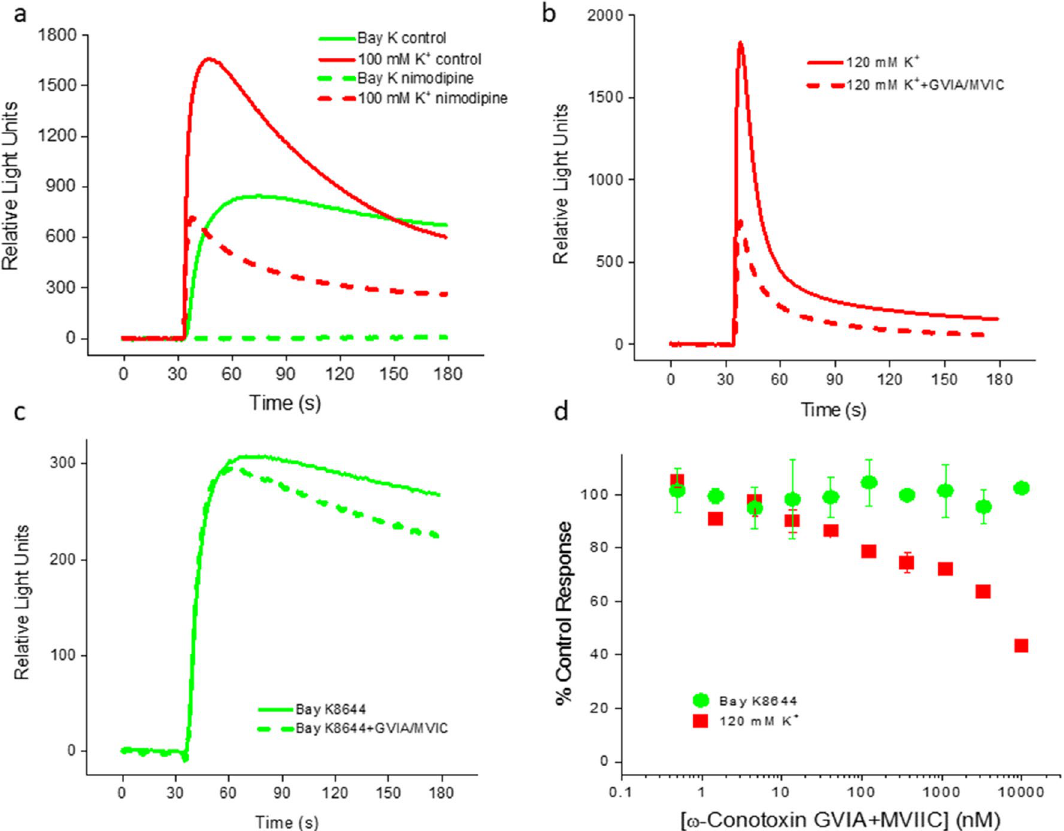
Figure 1. Functional expression of LTCCs and other VGCCs in rat cortical cultures. ( a ) Calcium fluorescent responses to stimulation by high [K + ] (100 mM; solid red line) and Bay K8644 (1.1 µM; solid green line). Nimodipine (3 µM) partially (dashed red line) and completely (dashed green line) inhibited the high [K + ]- and Bay K-evoked responses, respectively. ( b ) Calcium fluorescent responses evoked by high [K + ] (120 mM; solid line) were partially blocked by a cocktail of VGCC (but not LTCC) blockers (dotted line), ω-conotoxin GVIA (N-type) and ω-conotoxin MVIIC (N-, P- and Q-types), both at 10 µM. ( c ) Calcium fluorescent responses evoked by Bay K8644 (300 nM; solid line) were not sensitive to the cocktail (dotted line). ( d ) Concentration dependence of the cocktail effects on high [K + ]- and Bay K-induced responses. Summary of 4 independent experiments like those in ( b ) and ( c ). The holding [K + ] was 20 mM in all